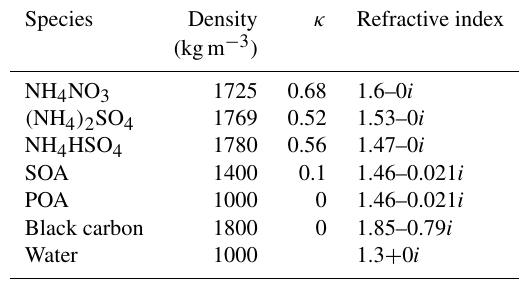
Table 2. Density, hygroscopicity parameter ( κ ), and refractive in- dices of pure composition used in this